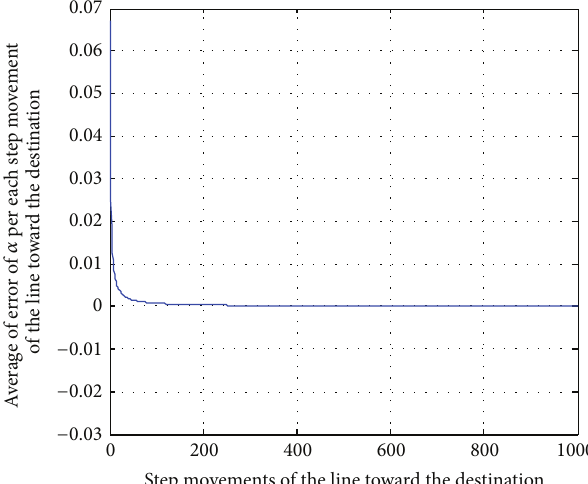
Figure 11: The variation of (average) error in degrees for 𝛼 with distance (shown in step movements away from the sensor up to 4000